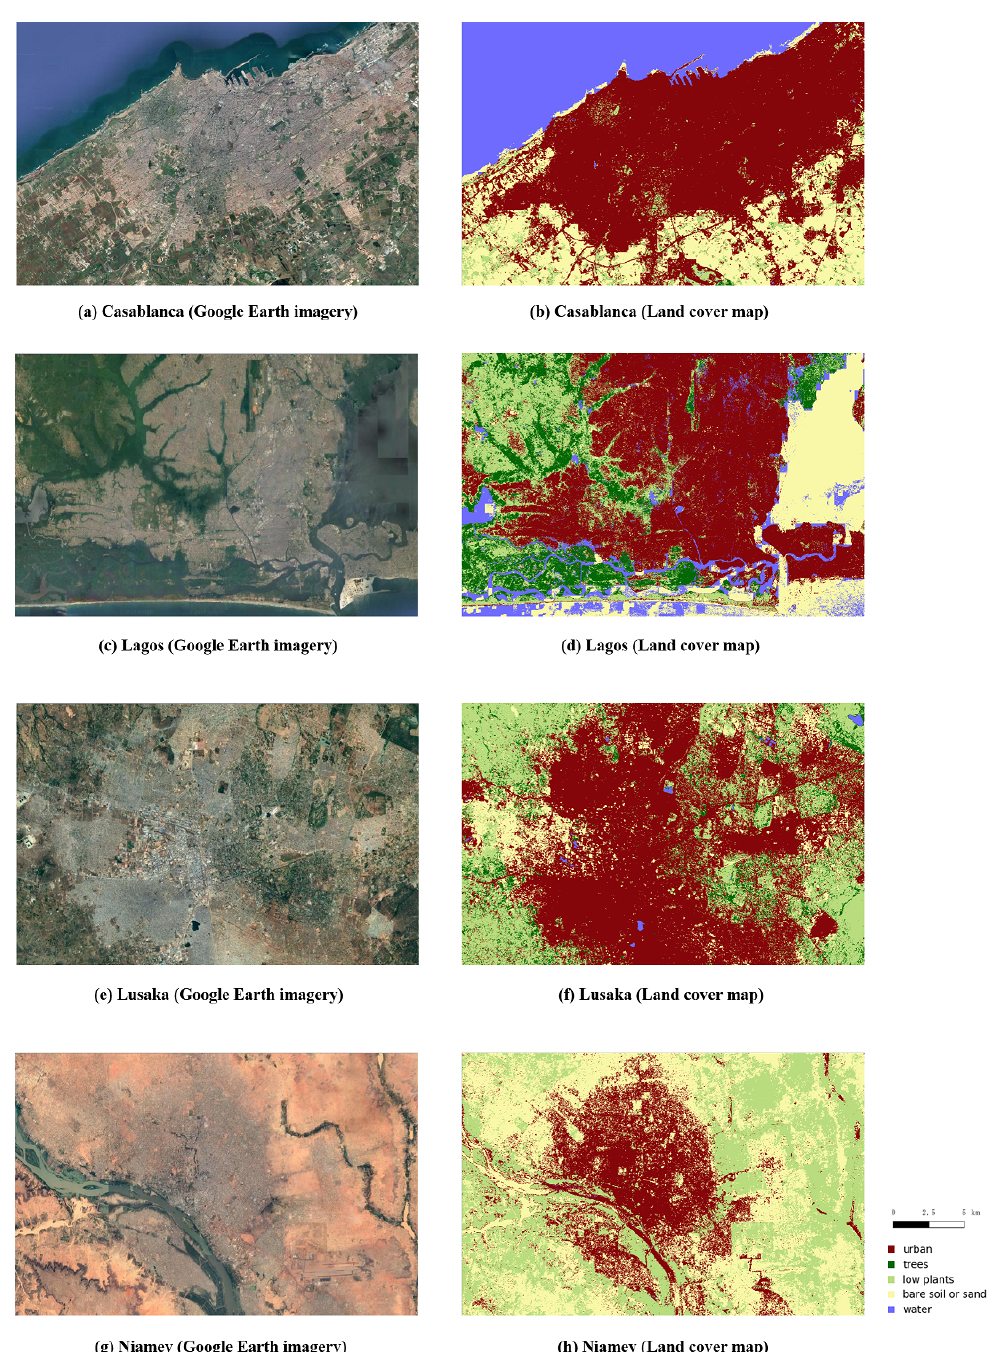
Figure 8. Visual results of experiments of “city-wise holdout cross